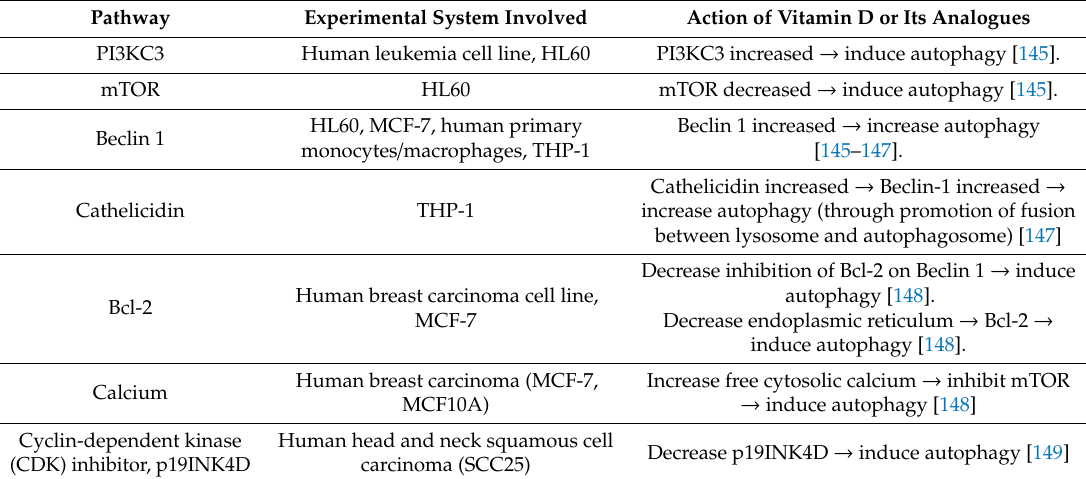
Table 1. Autophagy-related pathways induced by vitamin D and vitamin D